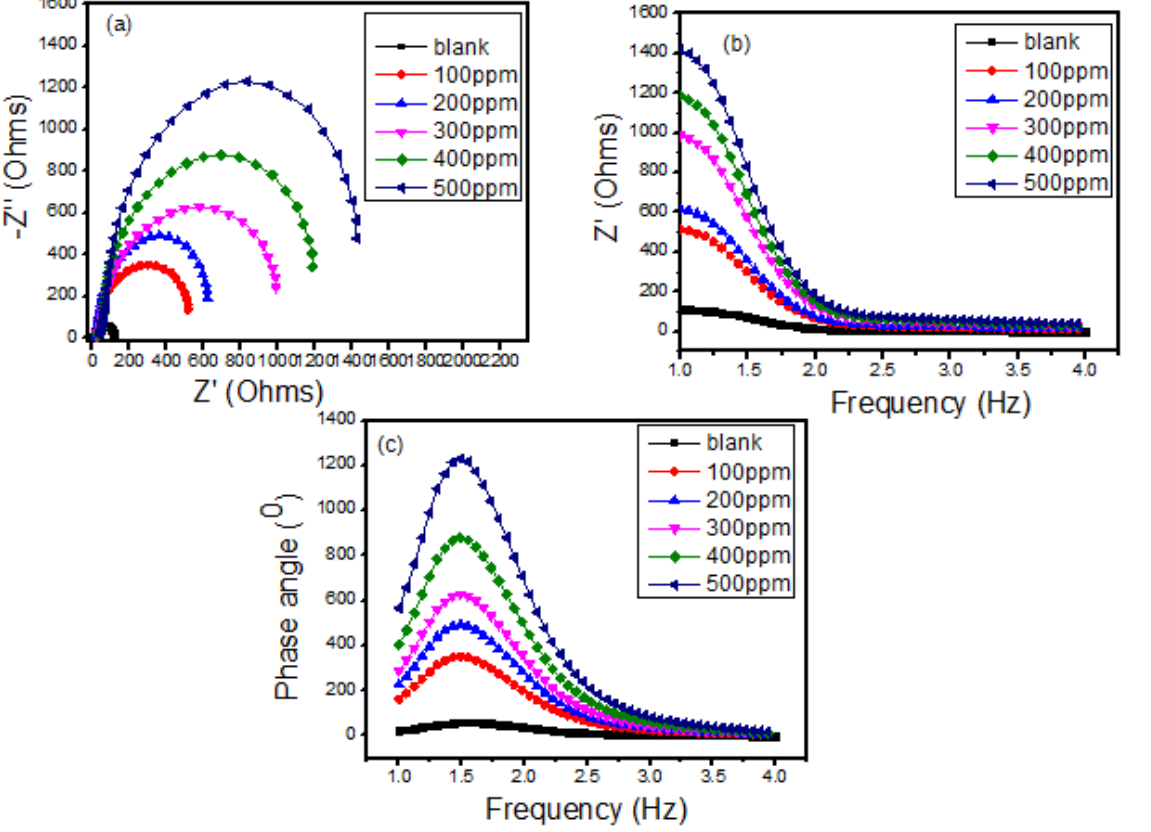
Figure 5. Electrochemical impedance Spectroscopy: ( a ) Nyquist Plot, ( b ) Bode plot, and ( c ) Phase angle plot.